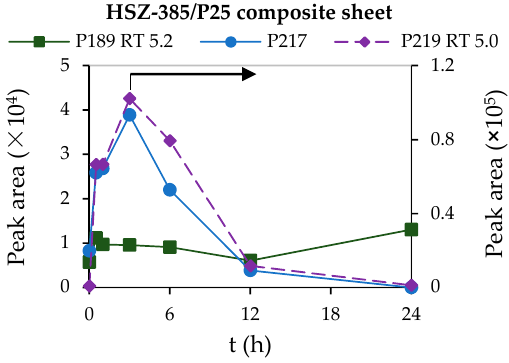
Figure 8. Changes in the peak areas of the major intermediates over time in ultrapure water when crotamiton was photocatalytically degraded using the HSZ-385/P25 composite sheet ( C 0 = 10 mg/L). The squares are P189 (retention time 5.2 min) and the circles are P217. The diamonds with a dashed line are P219 (retention time 5.0 min, secondary y -axis).